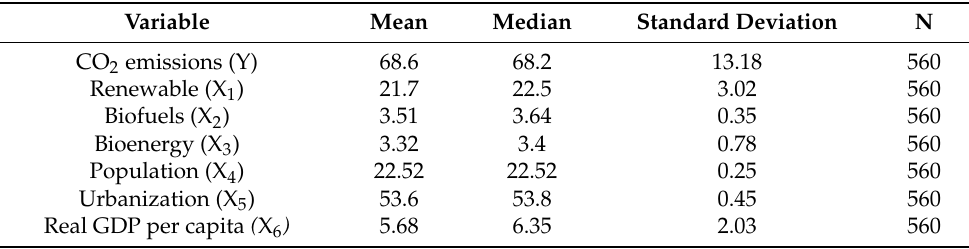
Table 3. Descriptive Statistics.